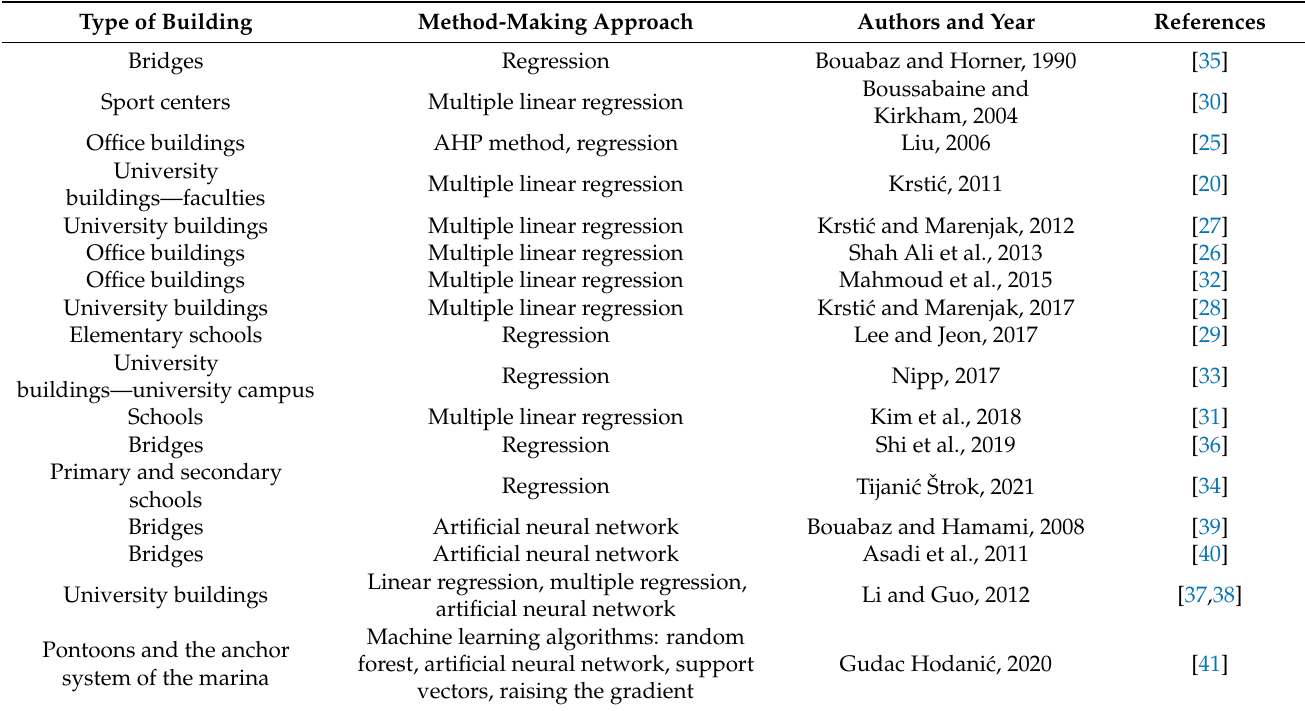
Table 1. Summary of the chronological survey on models for estimating and prediction of mainte- nance costs of different types of